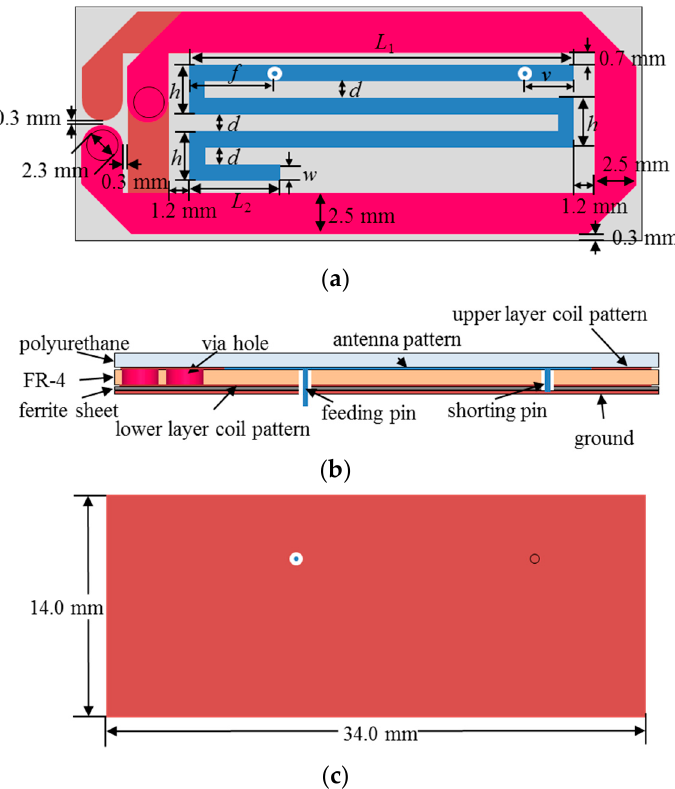
Figure 17. Measurement setup for ( a ) charging current and ( b ) voltage of the secondary cell.